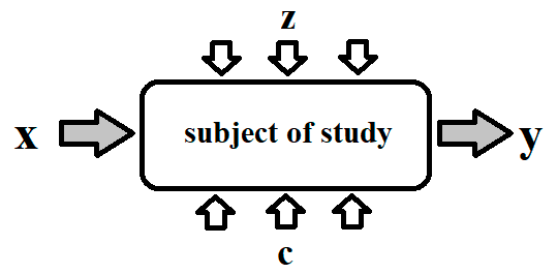
Figure 1. Block diagram of the research subject.